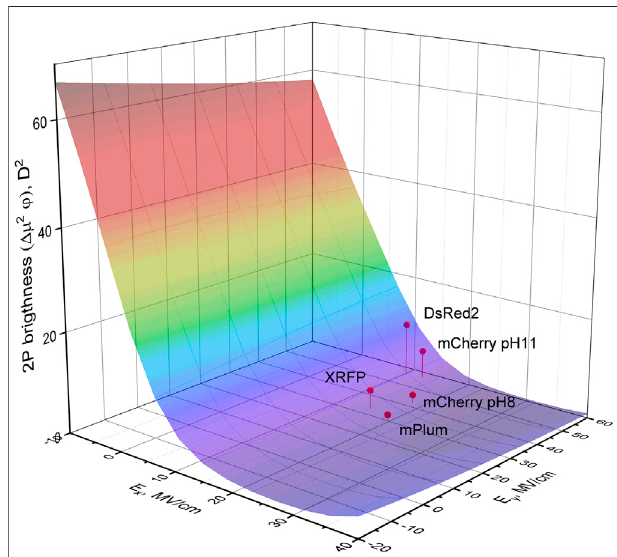
FIGURE 10 | 3D plot representing the 2P brightness (roughly proportional to Δ μ 2 φ ) in the region of the 0 – 0 excitation frequency as a function of E x and E y . Large brightness corresponds to red color on the surface and small brightness — to purple. Four representative RFPs are shown by red